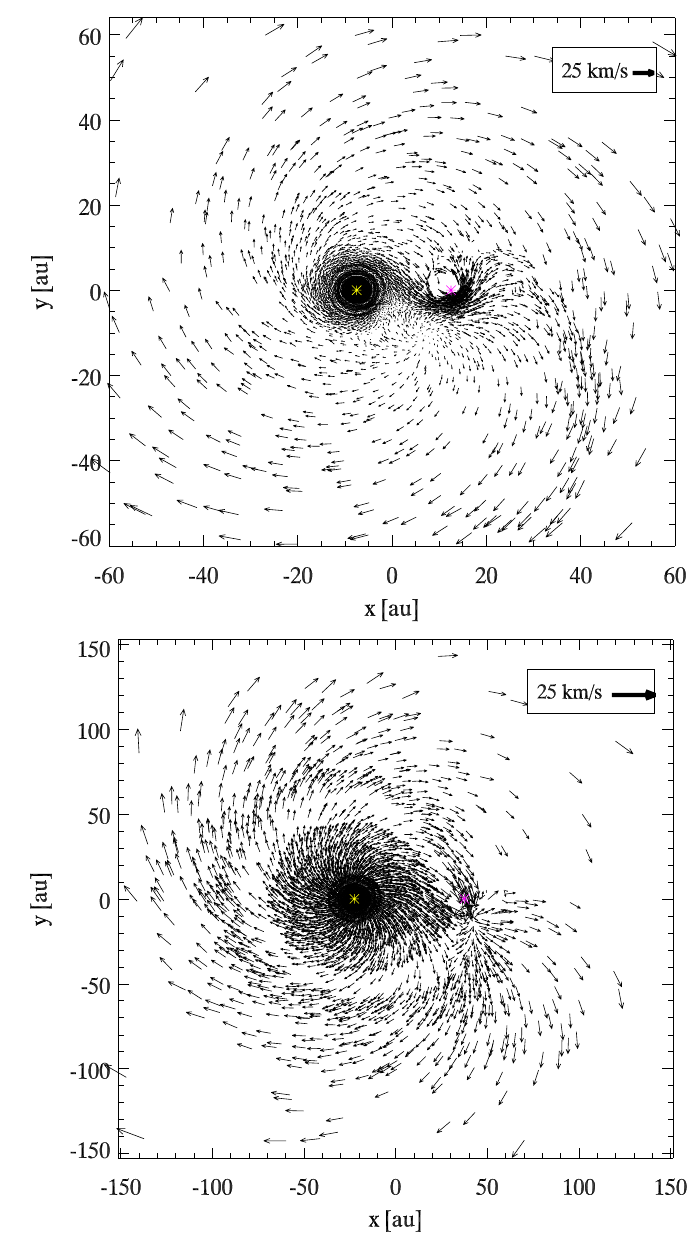
Fig. 1. The velocity (cid:13)ow structure in the stationary frame for models M1 (top) and M2 (bottom) in the orbital ( xy ) plane. The models consist of a 1 M ⊙ oxygen-rich Mira (left asterix) and an accreting 0.6 M ⊙ white dwarf (right asterix). The x - and y -axis labels are in AU